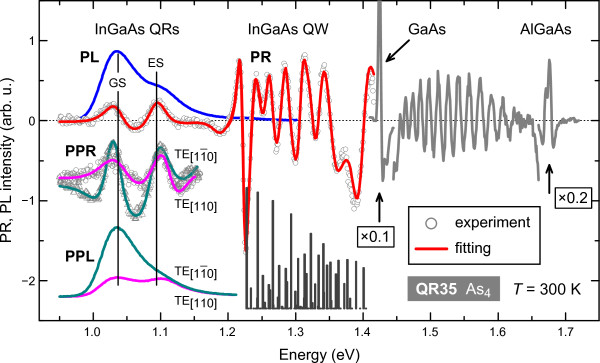
Room temperature PR and PL spectra of the As4-grown sample QR35. PPR and PPL spectra show a significant in-(001)-plane polarization anisotropy in the InGaAs QR-related interband transitions for the [11¯0] (green curves) and [110] (pink curves) polarizations. Vertical bars indicate numerically evaluated energies and relative strengths of the interband transitions in the InGaAs QW.